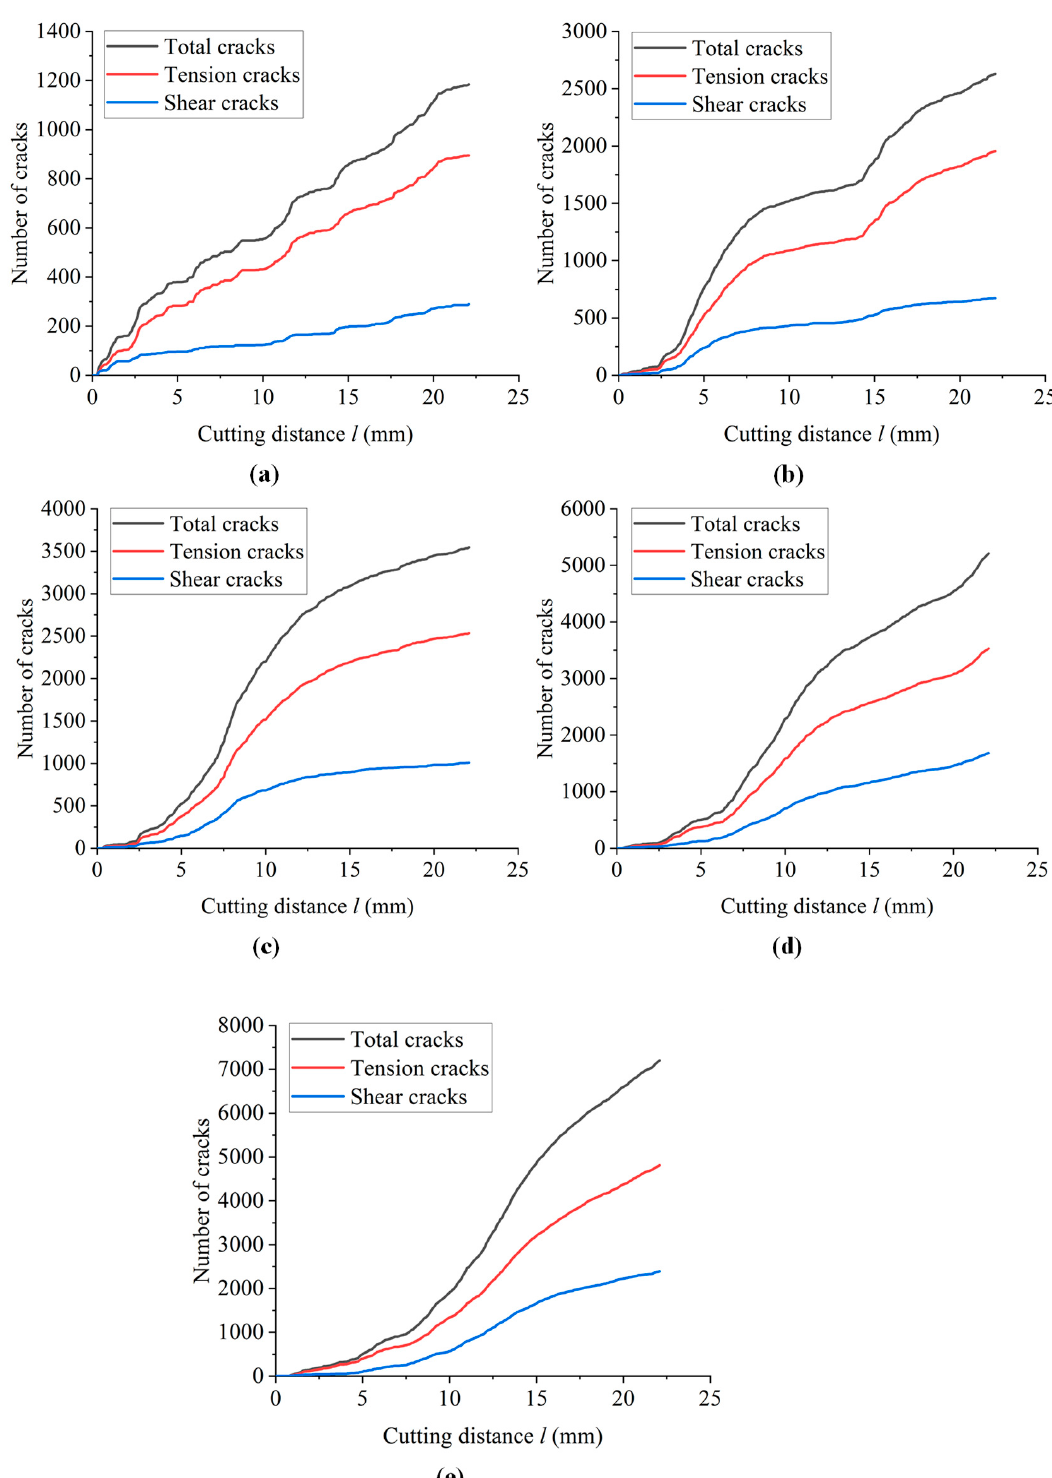
Figure 17. Variation characteristics of crack number of specimens with different cutting depths: ( a ) 5 mm; ( b ) 10 mm; ( c ) 15 mm; ( d ) 20 mm; ( e ) 25 mm.